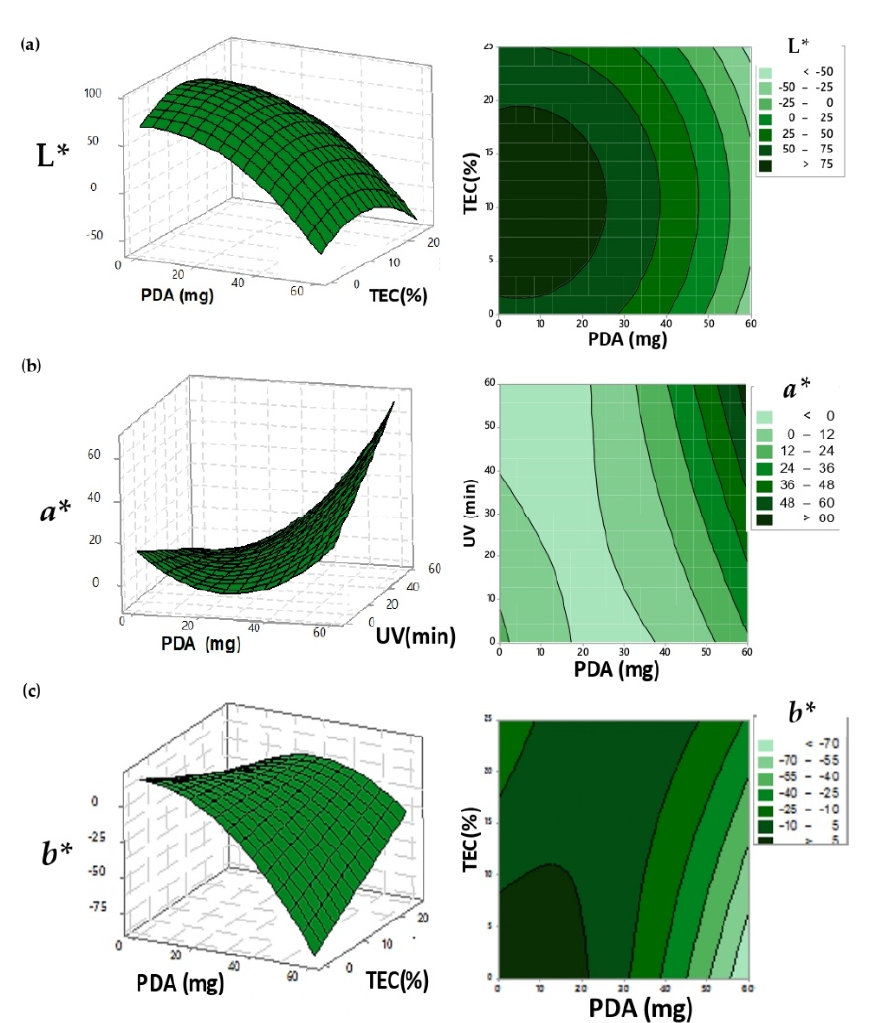
Figure 1. Response surface and contour graph for the surface adjusted for, respectively; ( a ) the L* value; ( b ) the a* coordinate and ( c ) the b* coordinate in the UV-irradiated-PDA films.